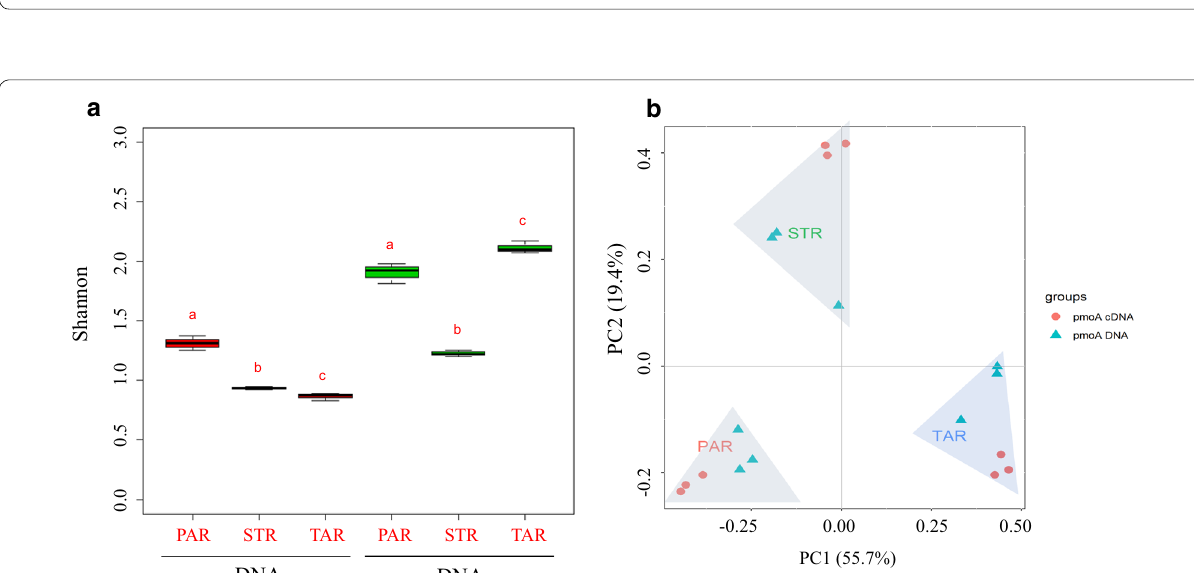
Fig. 5 Alpha diversity and beta-diversity of aerobic methanotroph calculation based on pmo A. The OTUs evenness of root microbiotas is shown by Shannon(a). The red boxplot based on DNA; the green boxplot based on cDNA. Error bars represent the standard error of the mean. Bars with the different letter (a, b or c) within a panel (DNA or cDNA) are significantly different (p < 0.05). The distance between samples of principal coordinates analysis (PCoA) (b) calculated using Bray–Curtis